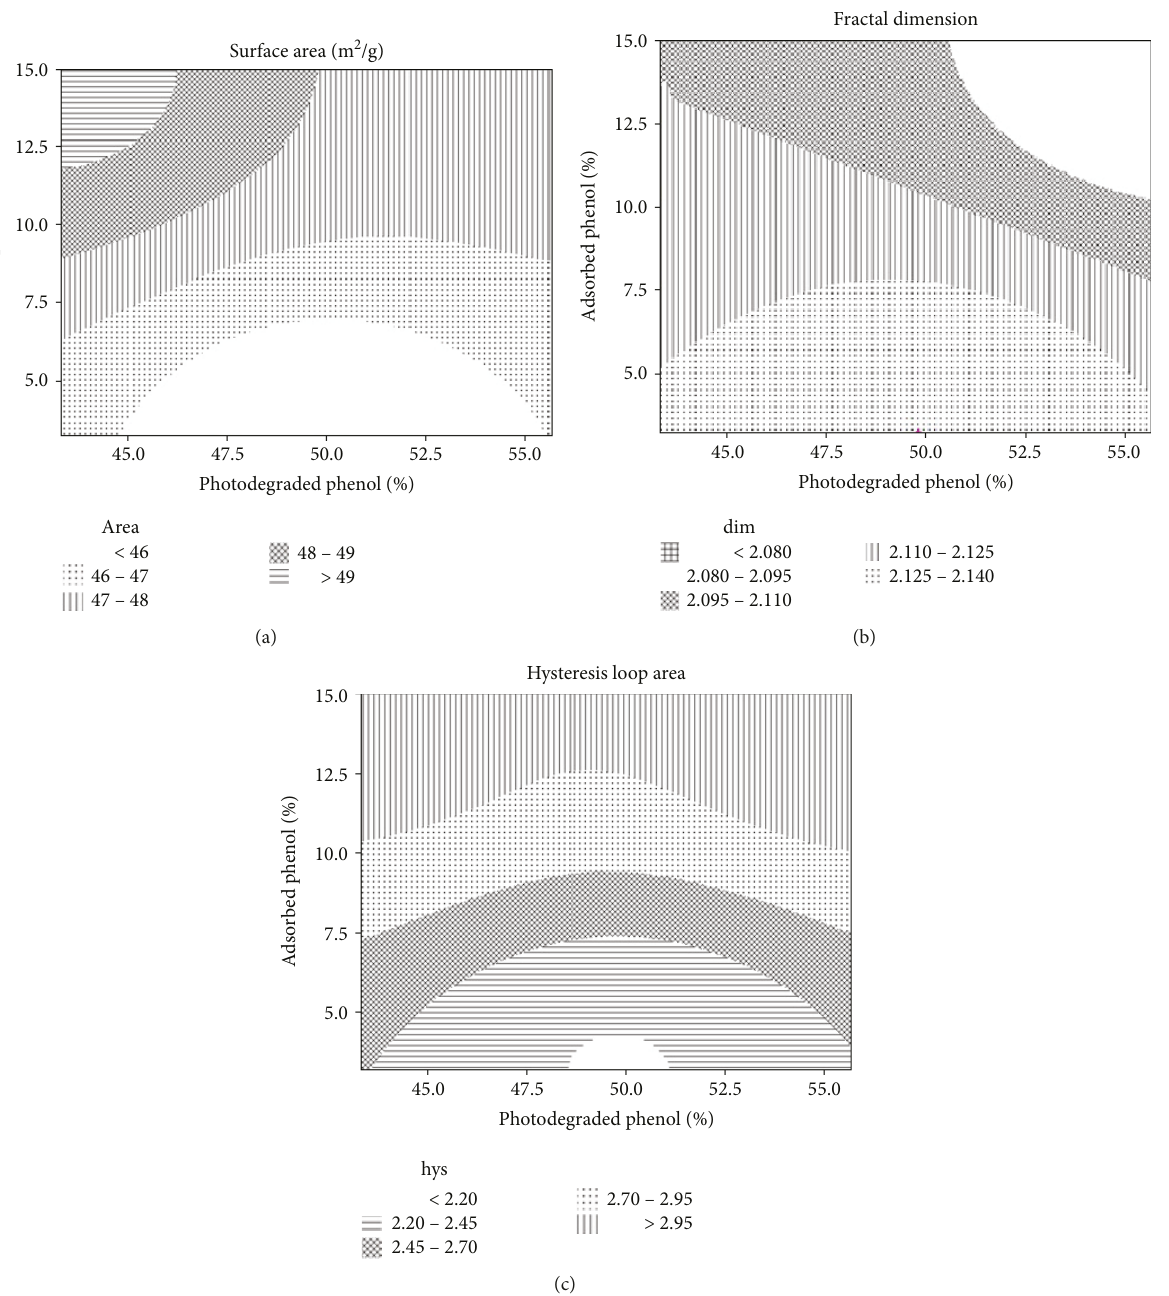
Figure 10: Relation between the textural parameters of the materials and their adsorption and phenol photodegradation